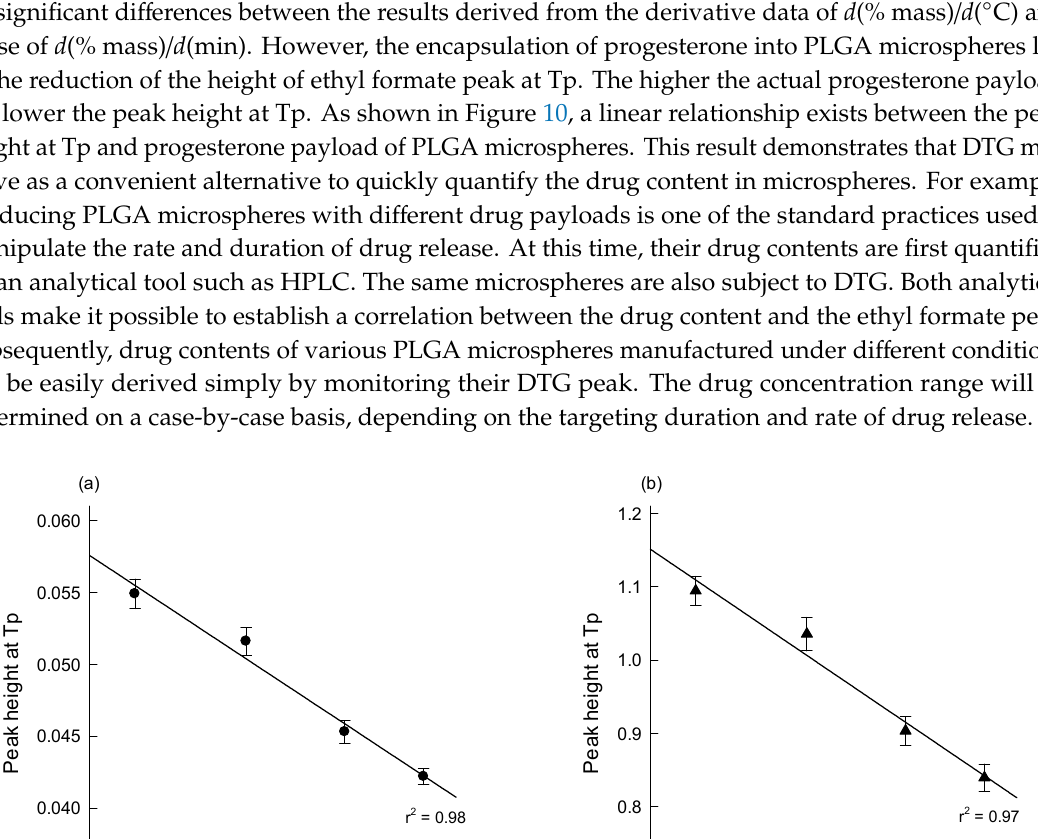
Figure S1. The size distribution patterns of PLGA microspheres prepared by methylene chloride (MC) and